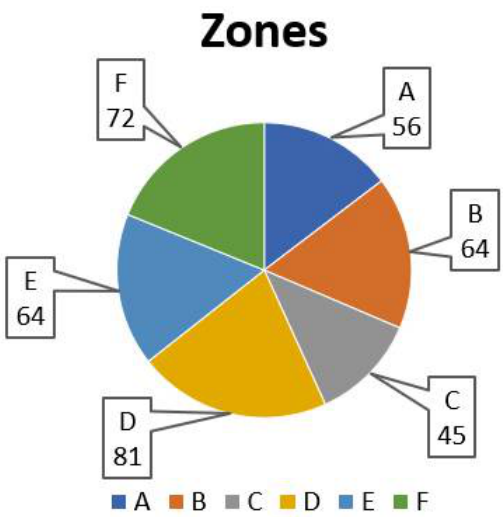
Figure 5. Number of speed humps in each zone.